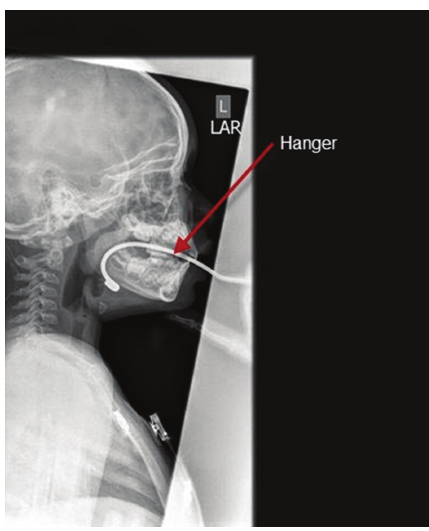
Figure 1: Lateral neck X-ray showing foreign body.